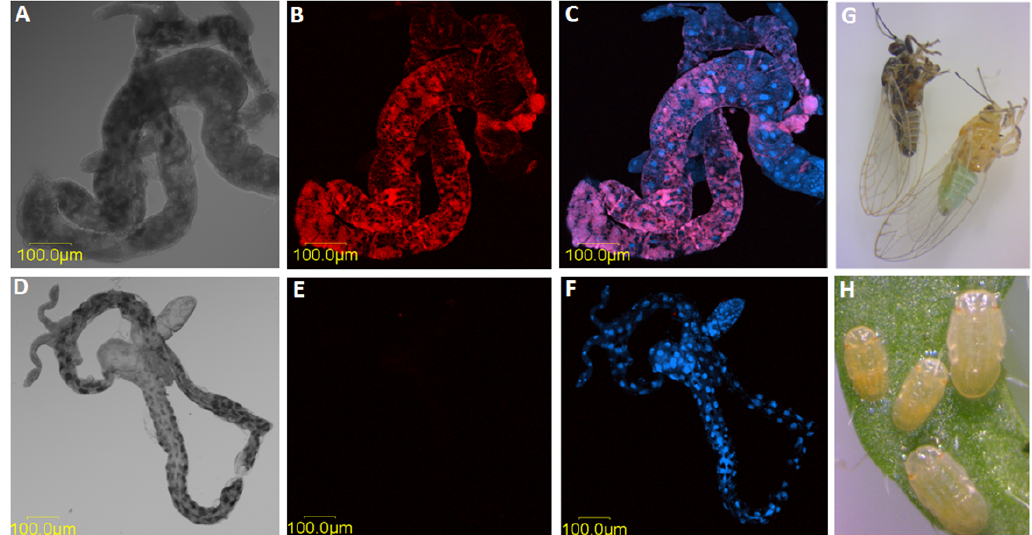
Figure 1. Midgut, nymphs, and adults used for sequencing. ( A ) Dissected midgut from CLso-infected adult psyllid under light microscope, and the same gut that was hybridized with a CLso-specific